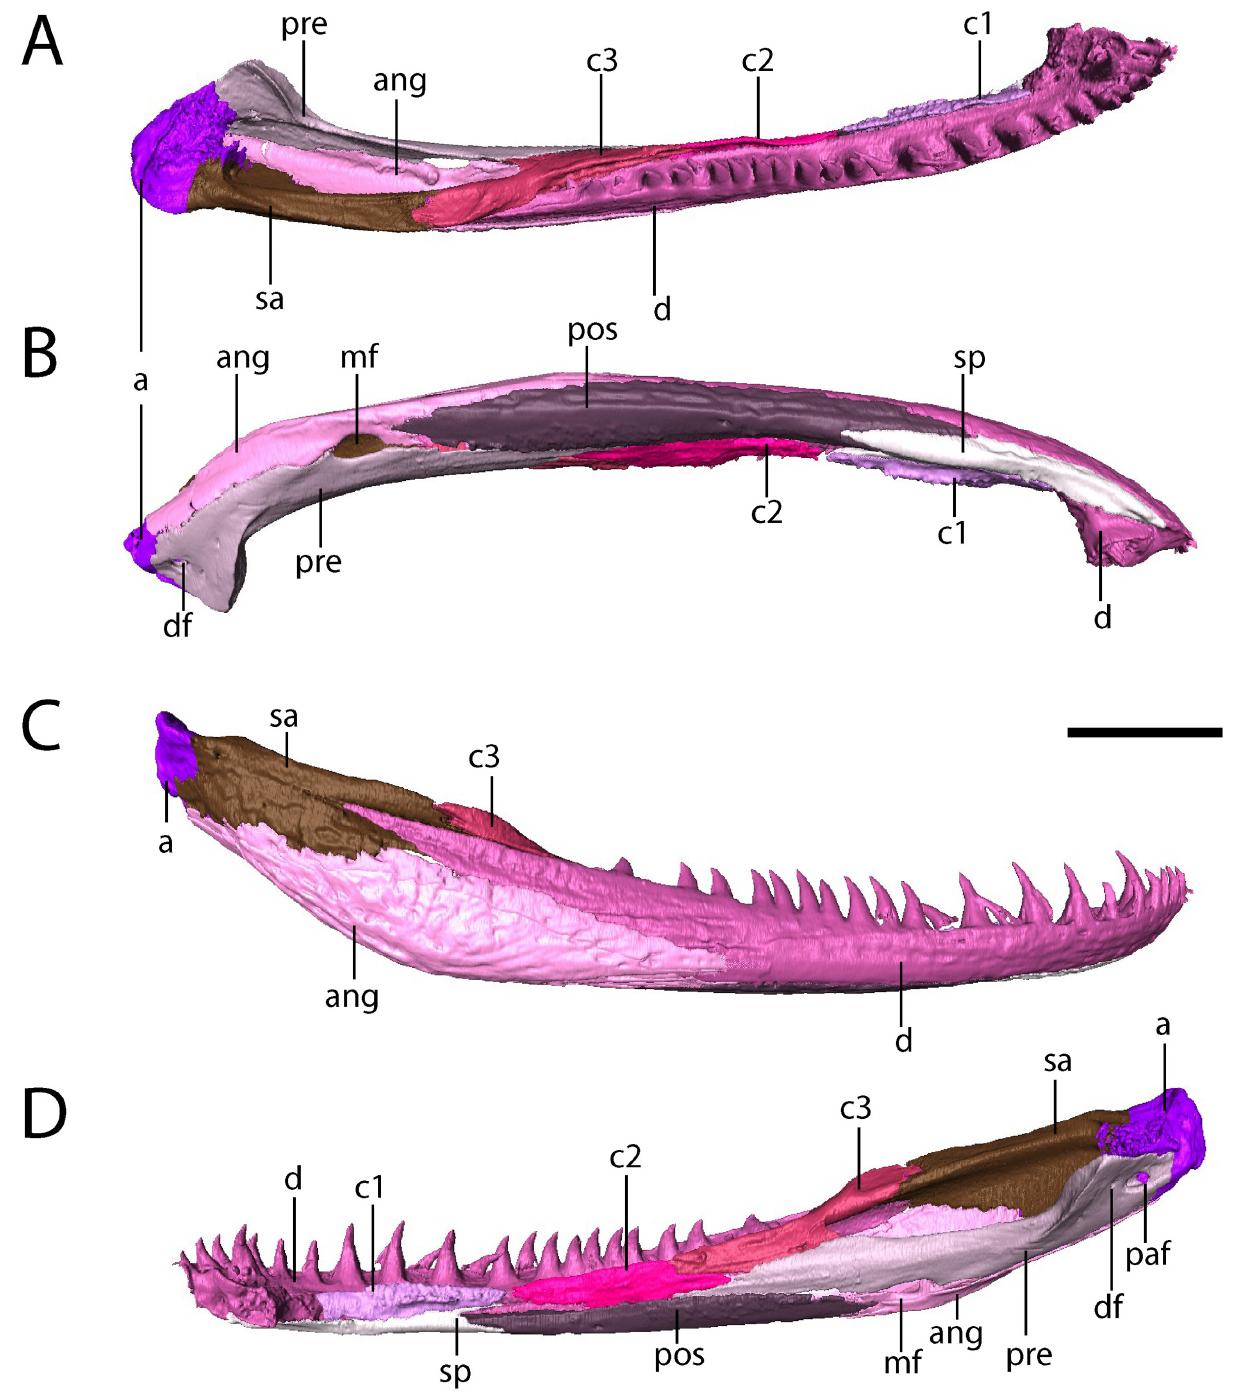
FIGURE 8 | OMNH 79318, cf. Acheloma , isolated renderings of the right mandible. (A) dorsal profile; (B) ventral profile; (C) lateral profile; (D) medial profile. Scale bar equal to 1cm.